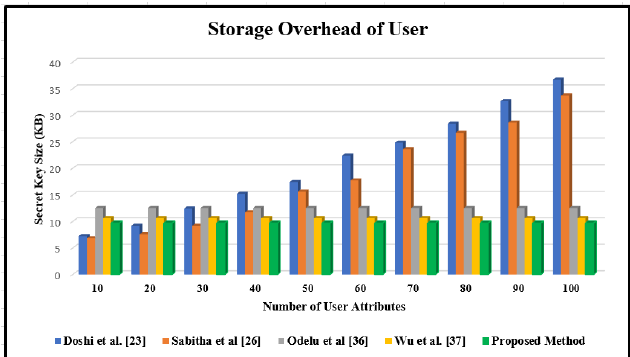
Figure 10. Secret key size at the user’s side.